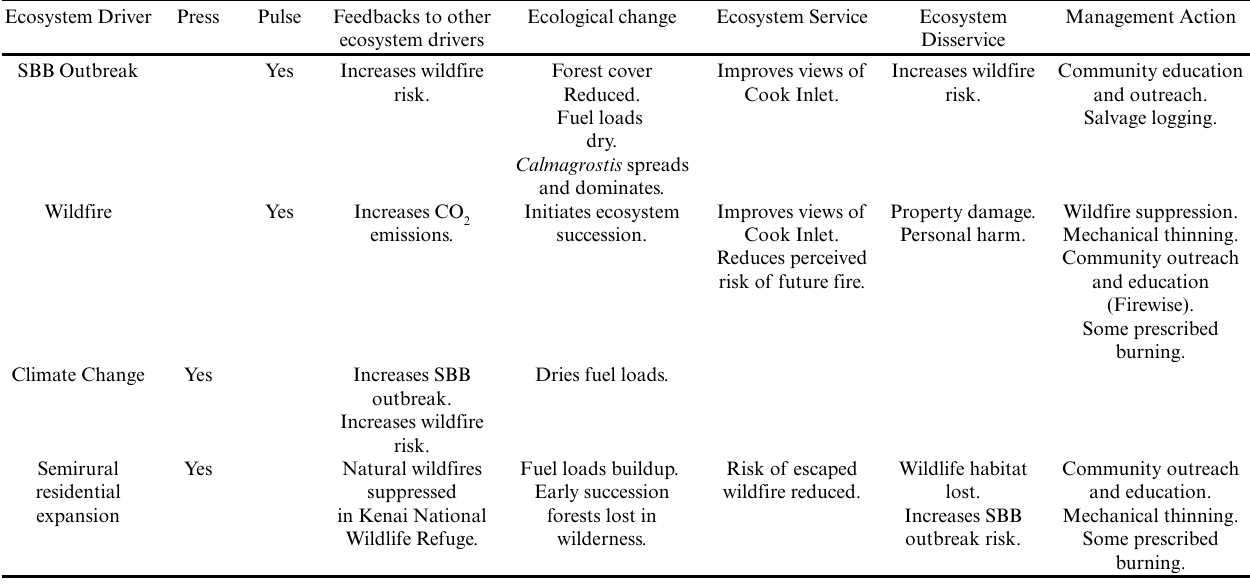
Table 1 . Press- and pulse-ecosystem drivers, feedbacks, ecological change, ecosystem services, disservices, and associated management actions on the Kenai Peninsula, Alaska. SBB = spruce bark beetle ( Dendroctonus rufipennis ). Ecosystem